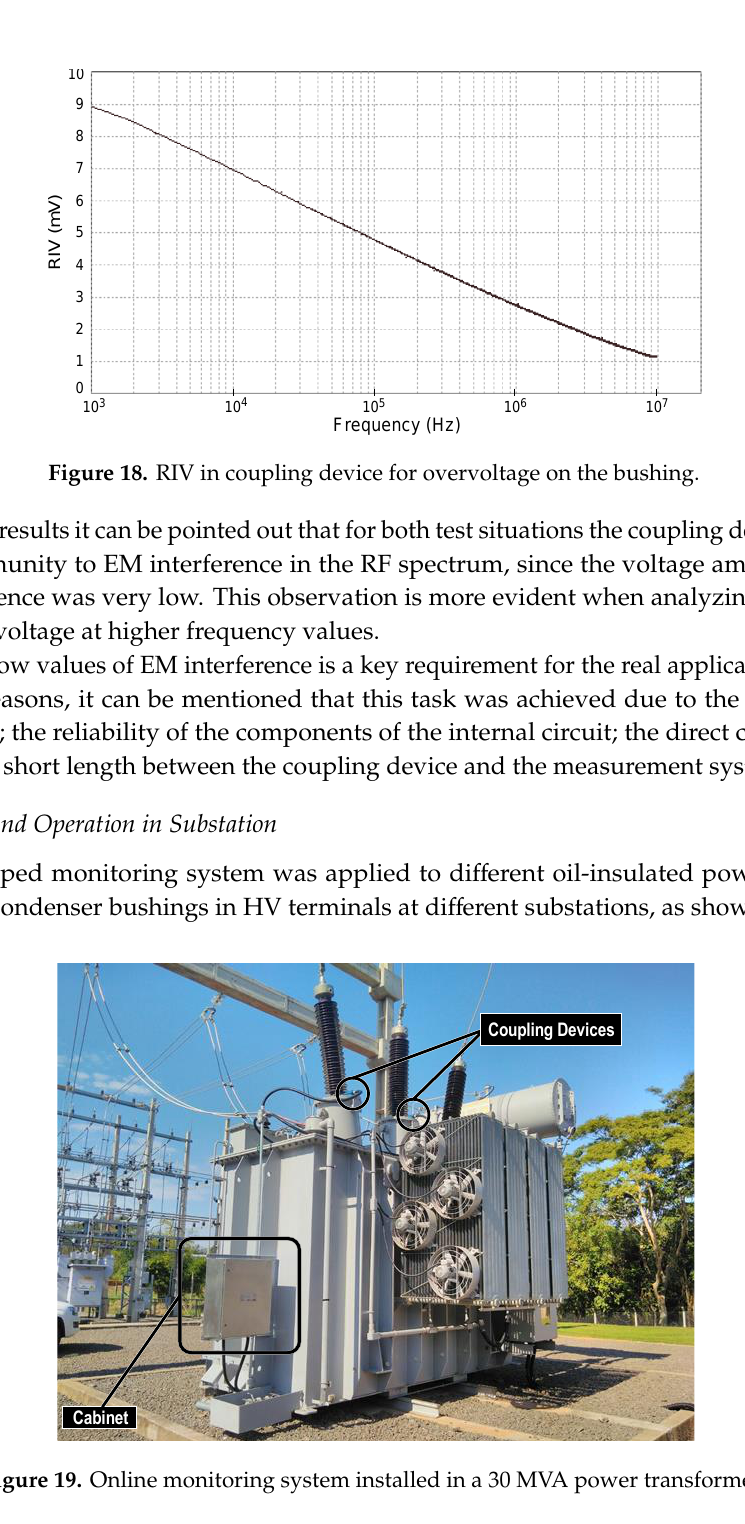
Figure 17. Radio interference voltage (RIV) in coupling device for nominal phase-to-ground voltage on the bushing.